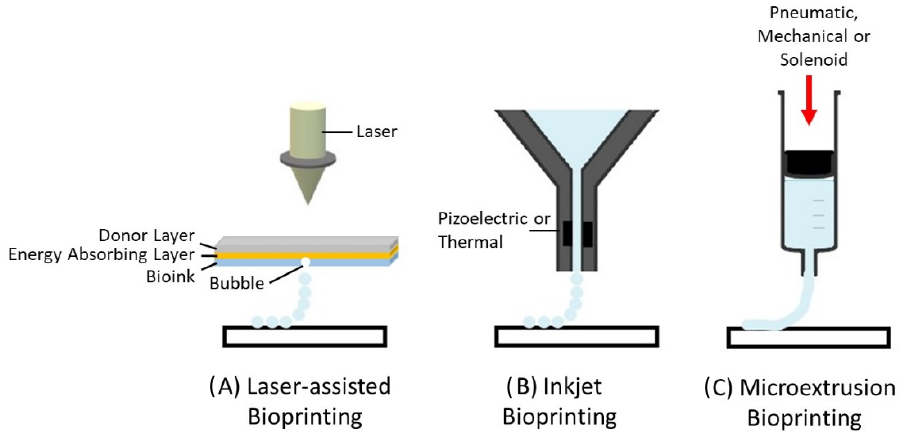
Figure 1. Types of 3D bioprinting. ( A ) Laser-assisted bioprinting, ( B ) inject bioprinting, ( C ) micro- extrusion bioprinting.